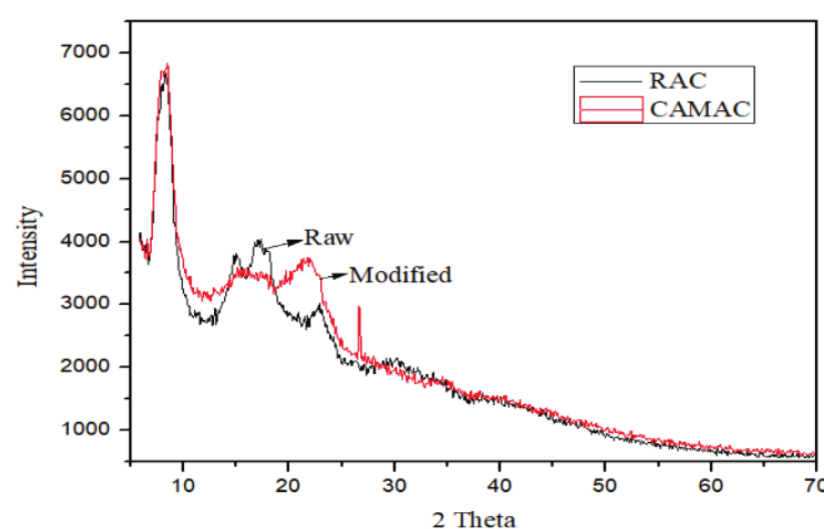
Fig. 2 – X-ray diffraction (XRD) pattern of raw Acorus calamus (RAC), and citric acid modified Acorus calamus (CAMAC)